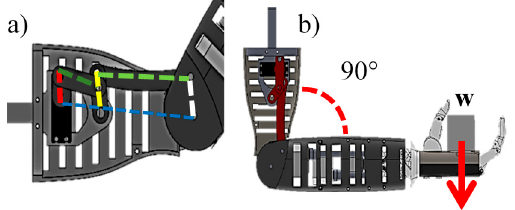
Figure 9. Degrees of amputation. ( a ) Schwartz classification. ( b ) Level of amputation to be optimized. ( c ) Mechanism to optimize.